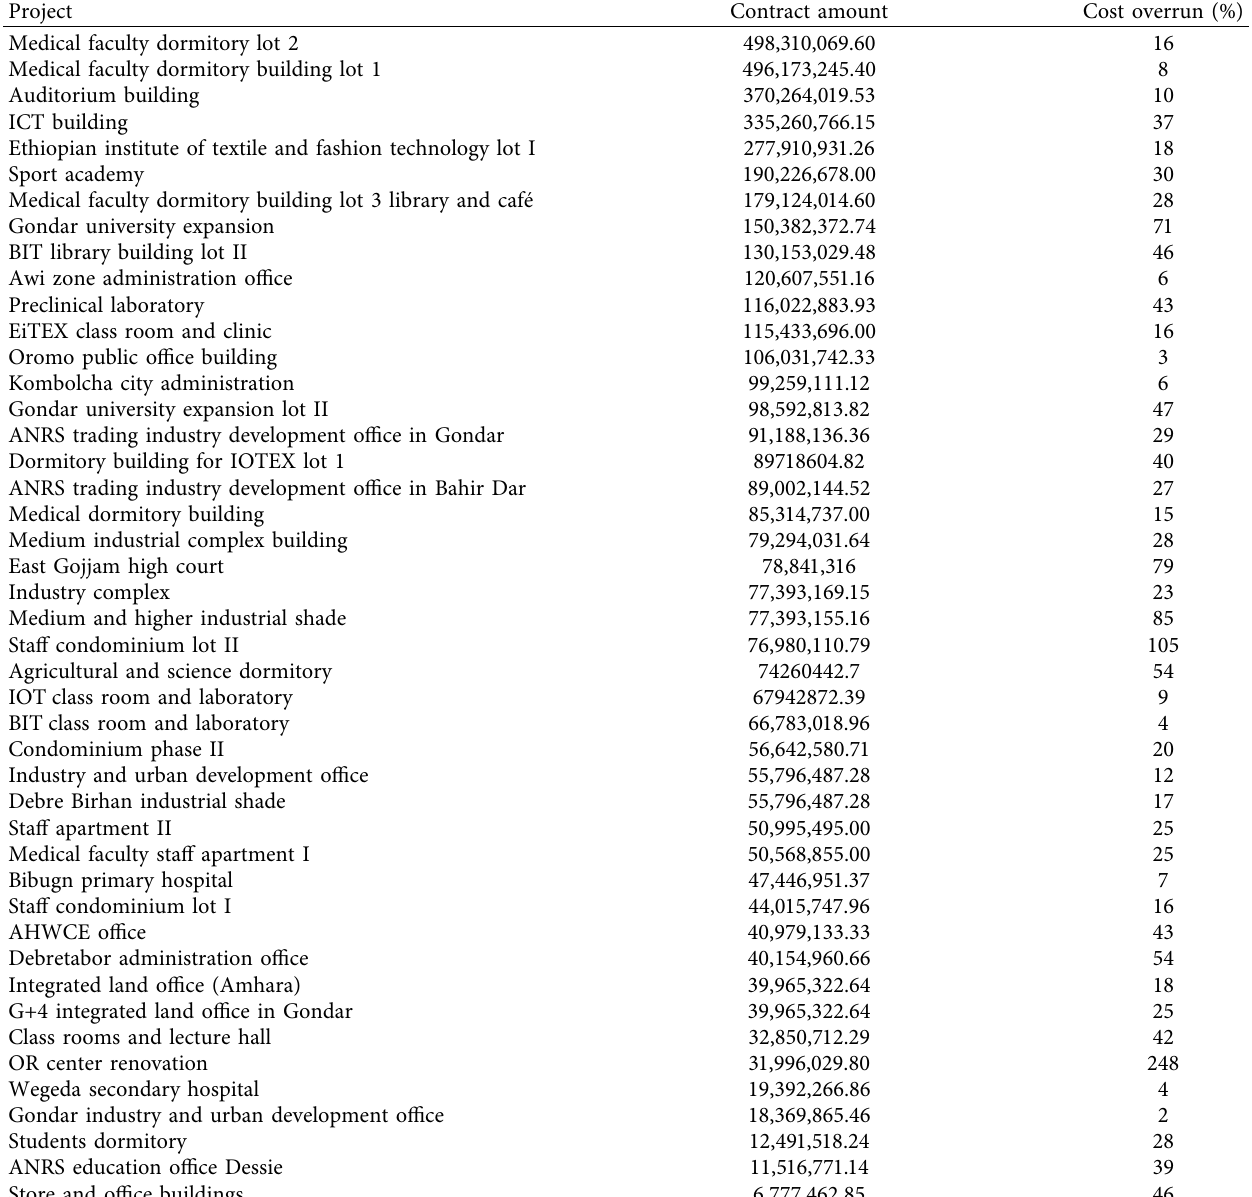
Table 3: Cost data for building construction